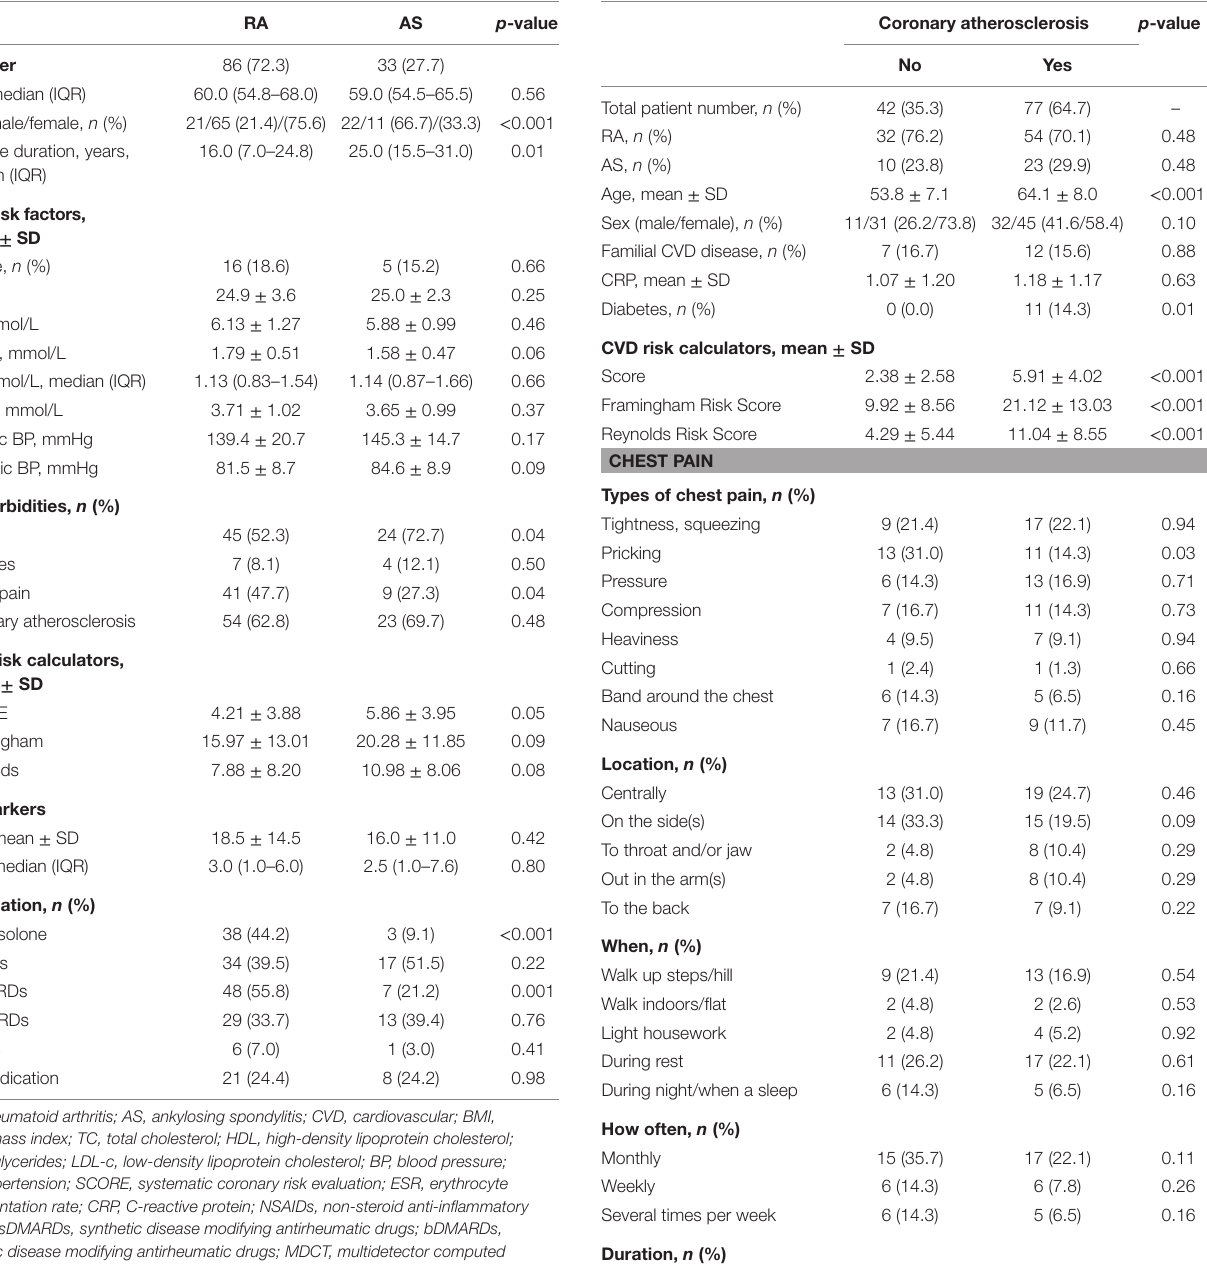
TaBle 2 | coronary atherosclerosis in relation to cardiovascular risk factors and chest pain in patients with ra and as.